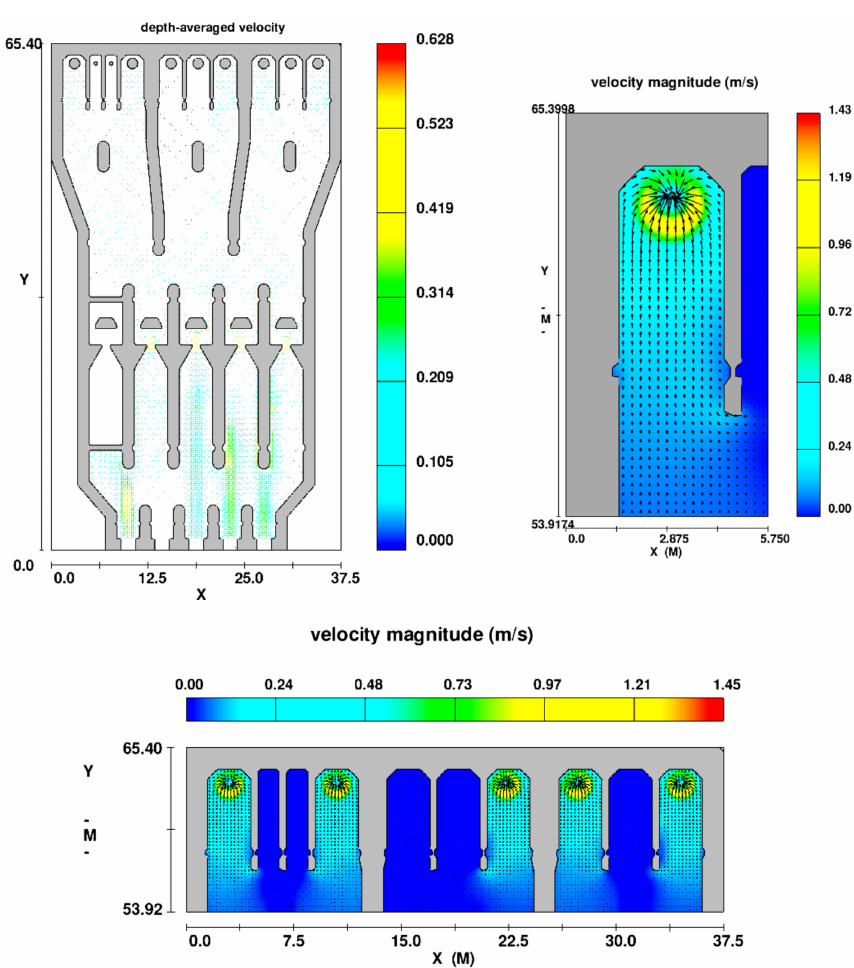
Figure 14. Field vector of velocity at the basin for scenario V—3D model.